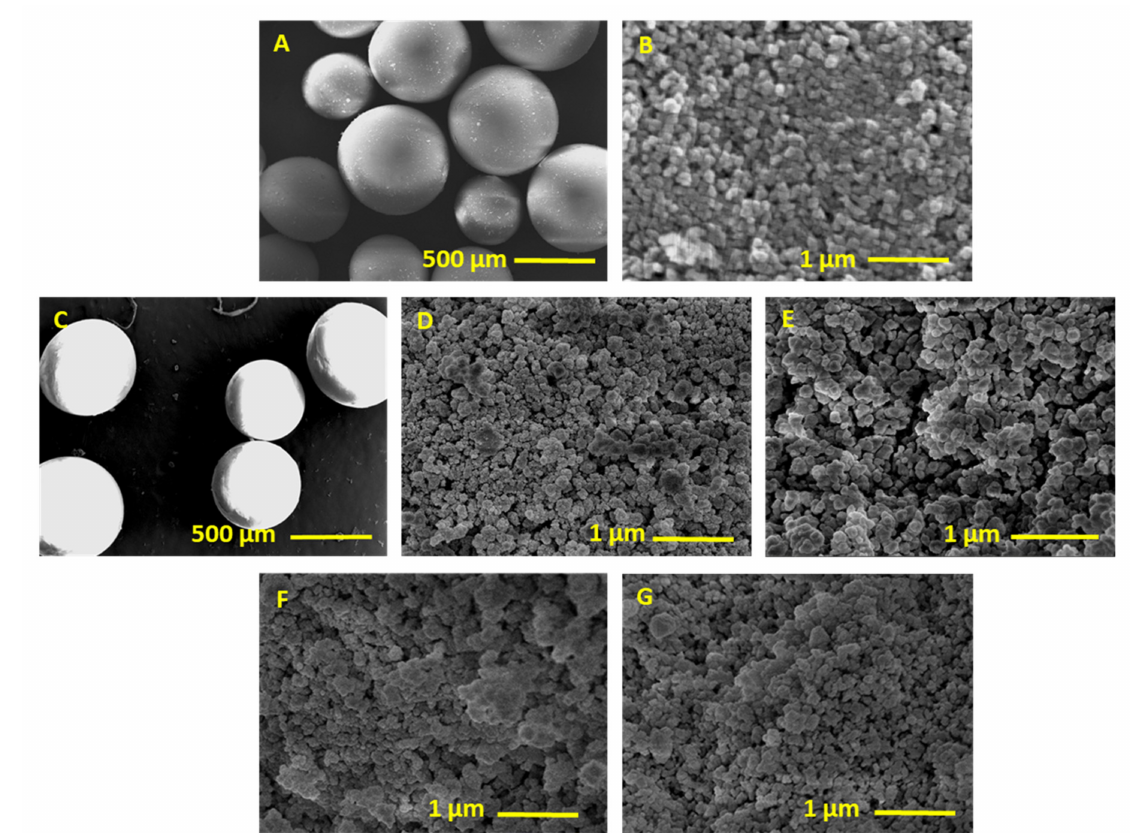
Figure 2. SEM images of ( A ) the parent zeolite Beta beads; ( B ) the surface morphology of the parent zeolite Beta beads; ( C ) Sn-deAl-1.8-Beta-B; ( D ) the surface morphology of Sn-deAl-1.8-Beta-B; ( E ) the surface morphology of Sn-deAl-7.2-Beta-B; ( F ) the surface morphology of Zr-deAl-1.8-Beta-B; and ( G ) the surface morphology of